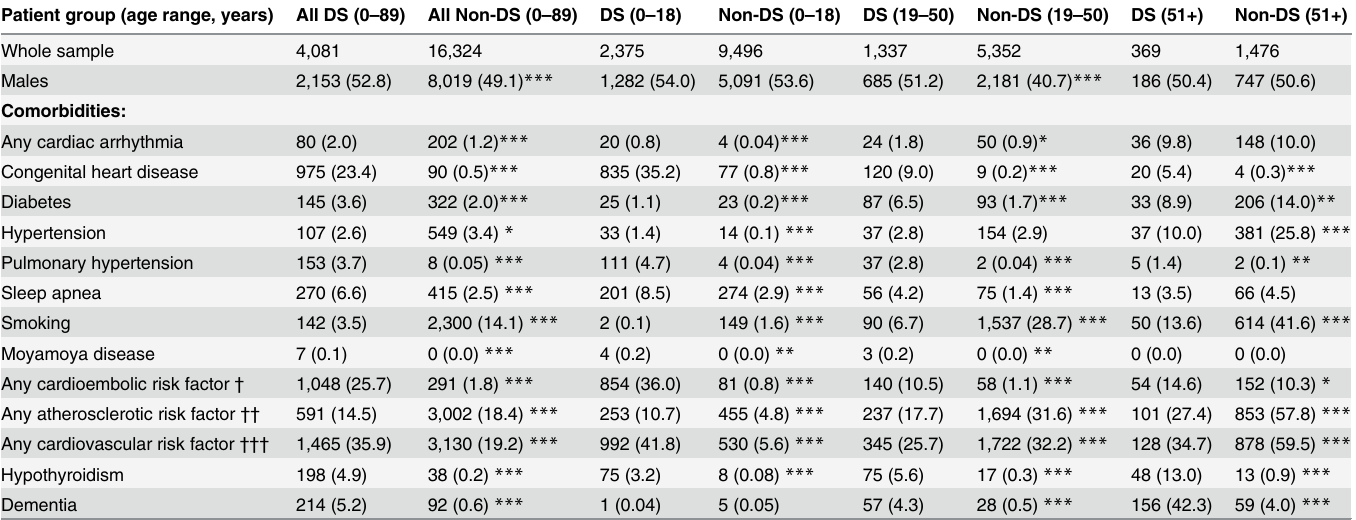
Table 1. Sample characteristics. (Data are n [%] patients unless indicated